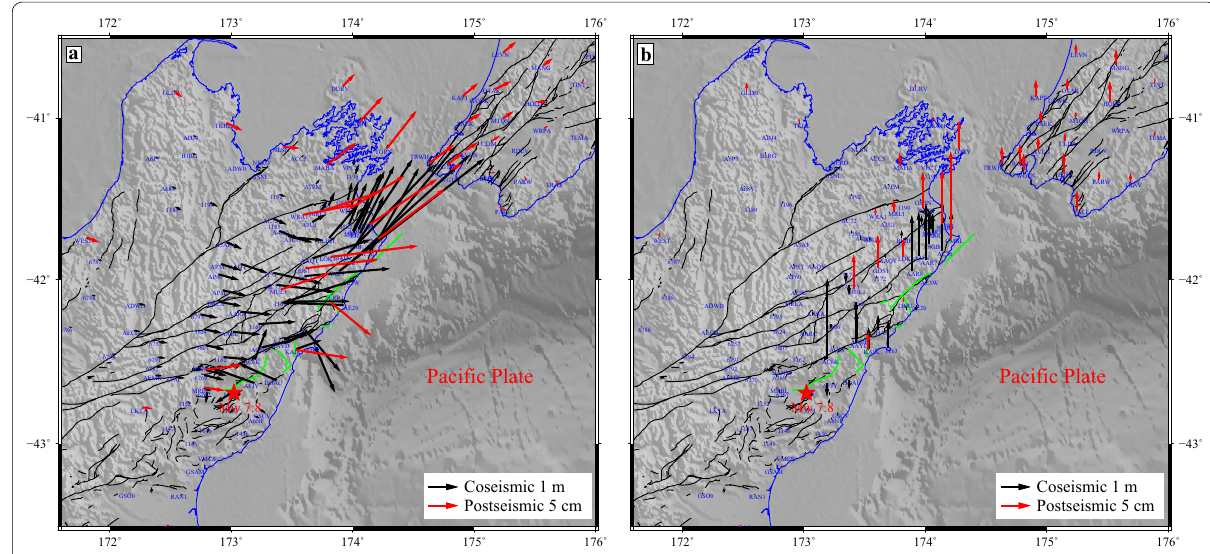
Fig. 4 GPS coseismic and postseismic deformation fields of the Kaikoura earthquake. a and b Horizontal and vertical displacement fields with coseismic deformation (black arrows) and postseismic 180-day deformation (red arrows),